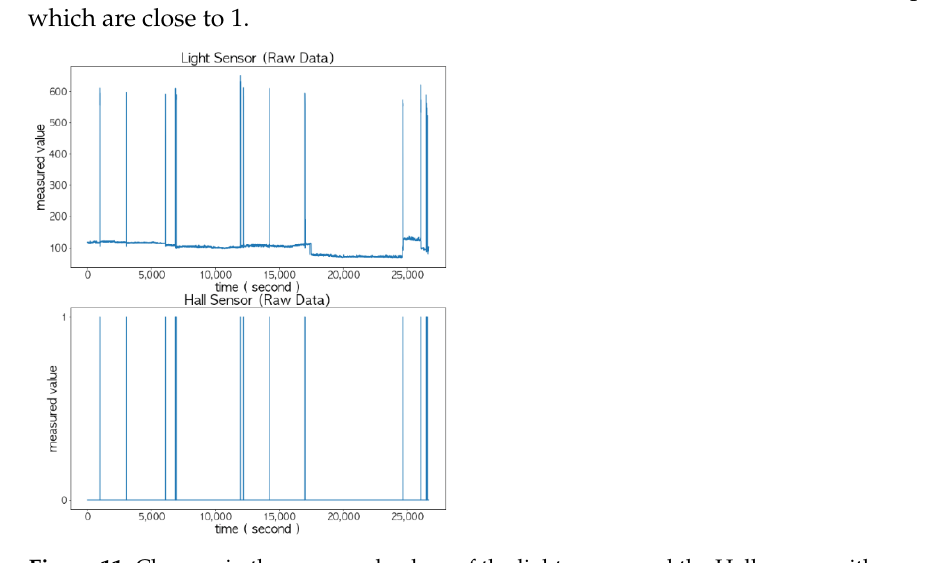
Figure 12. Determination of the opening and closing status of the door by combining the light sensor and the Hall